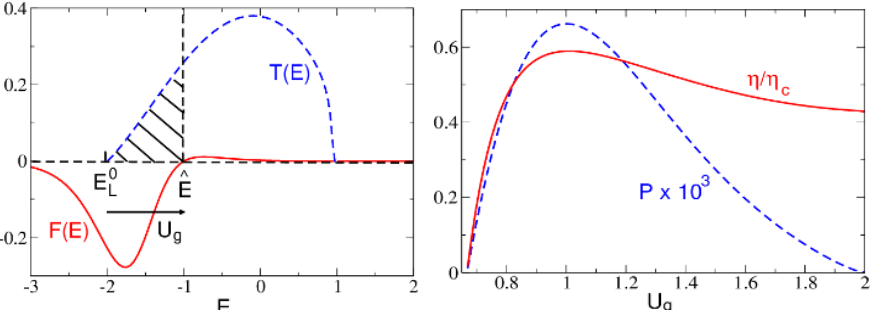
Figure 3. Left panel : transmission function for a weakly disordered wire of length L = 20 in units of = − 2.005 the lattice spacing and localization length ξ 0 = 10 L . The lower impurity band edge is at E 0 L Difference of the Fermi functions F ( E ) = f H ( E ) − f C ( E ) (solid black curve) with T H = 0.5, µ H = 1.0, µ C = 1.68, and ˆ E = 1.7. A gate voltage corresponding to U g = 1 will move E 0 and align it with L ˆ E . Right panel : the efficiency η / η c and power output P as a function of the gate voltage, using the parameters chosen in the left panel. Maximum power occurs at U g = 1, where the lower band edge aligns with ˆ E . At the same time, there exists a wide range of U g for which η / η c > 0.3 and P is near the peak value